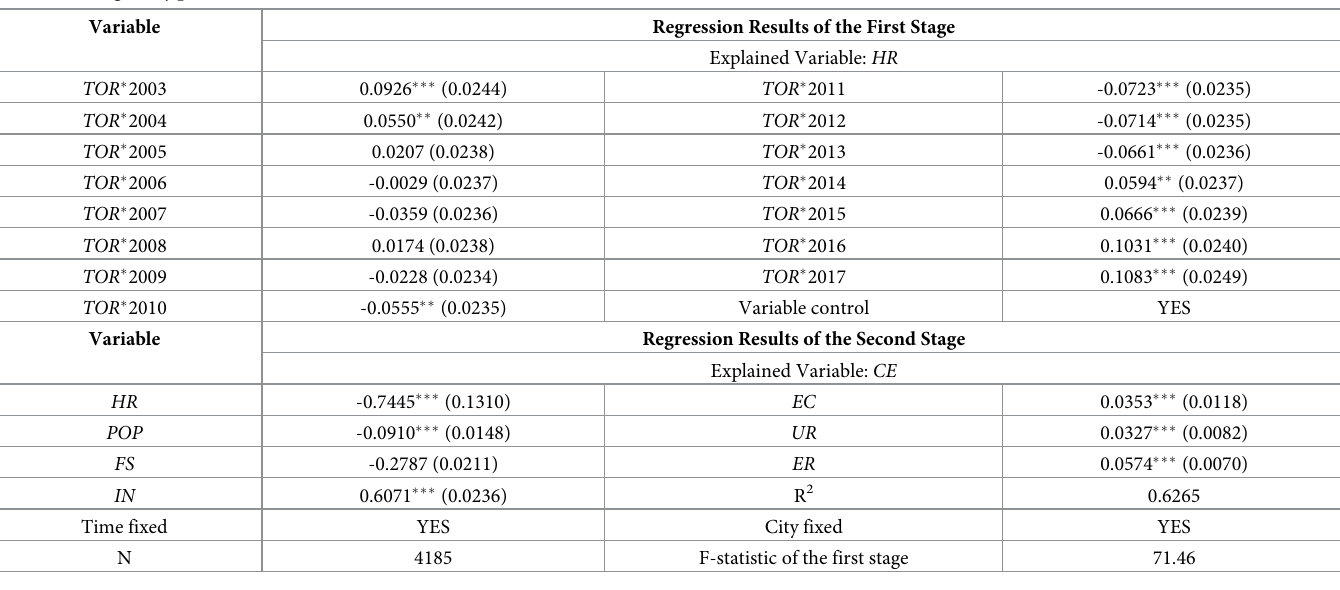
Table 4. Endogeneity problem. Variable Regression Results of the First